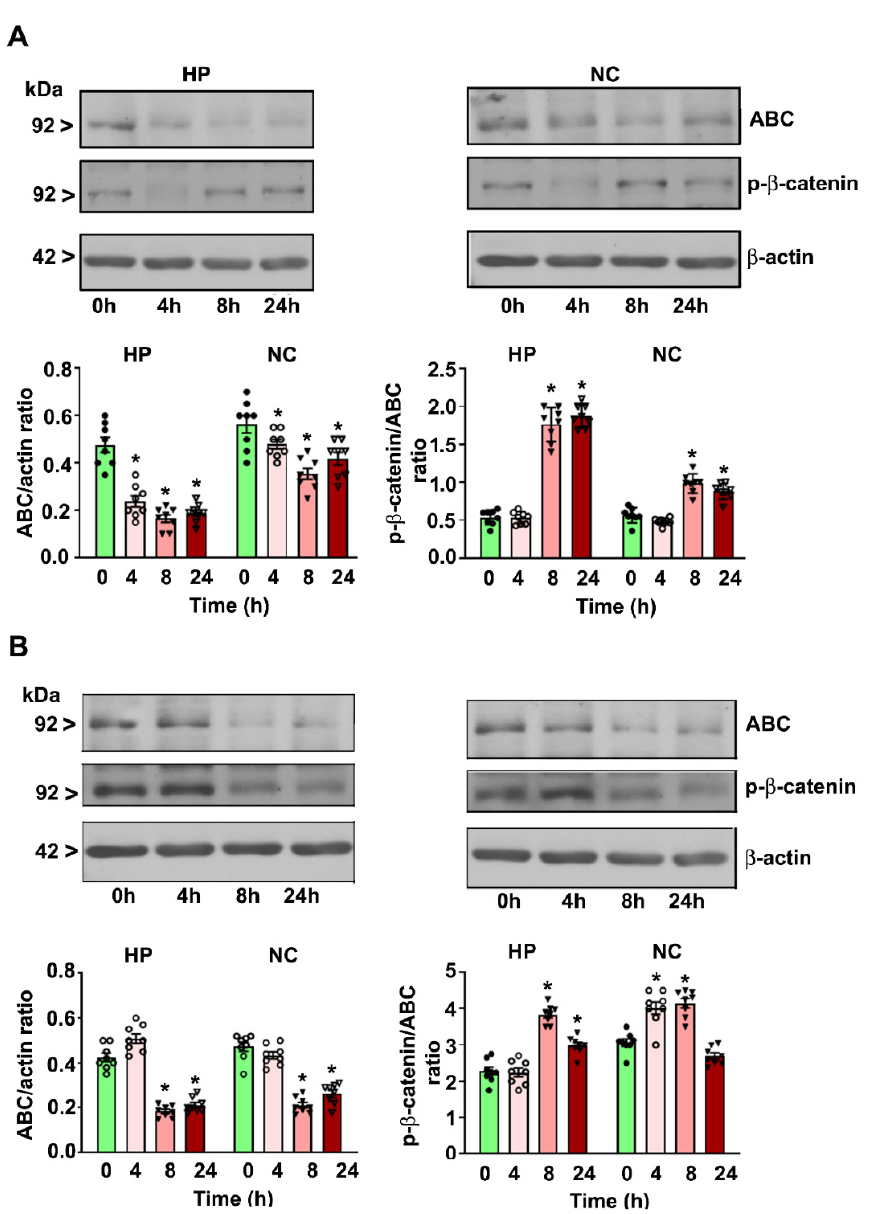
Figure 2. Decreased cytosolic active- β -catenin (ABC) and p- β -catenin protein levels in the P7 mouse HP and NC tissues in response to moderate- and high-dose ethanol exposure. The HP and NC cytosolic extracts obtained 4–24 h after the first saline or moderate-dose ( A ) / high-dose ( B ) ethanol exposure. The ABC and p- β -catenin protein levels were determined using Western blot analysis. The protein samples were equally loaded, confirmed with Ponceau S staining, and normalized to β -actin. For the 0 h ethanol group, saline was administered. Error bars, SEM (* p < 0.05 vs. the saline [0 h] group, n = 8 pups/group).